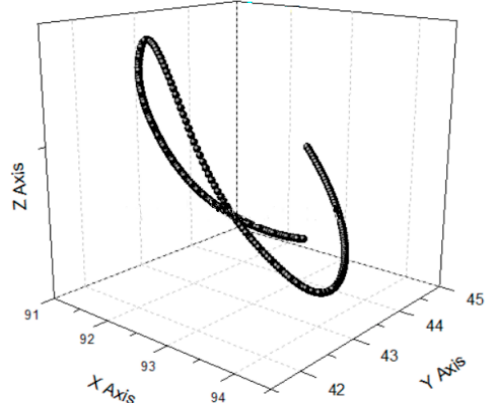
Figure 37. Output trace No. 1.